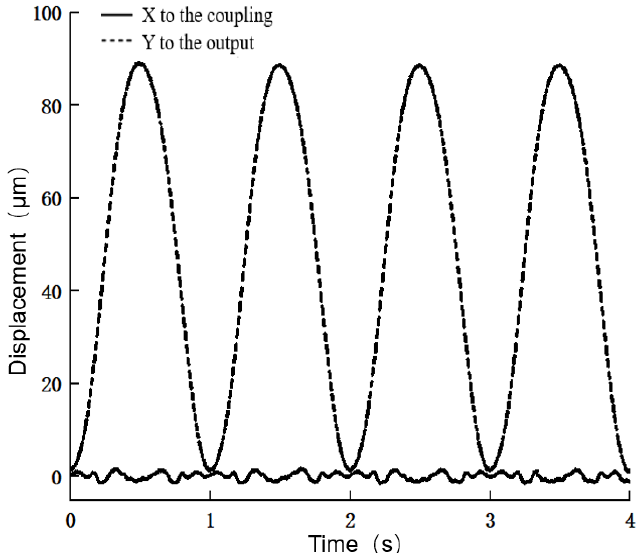
Figure 4. Coupling effect.